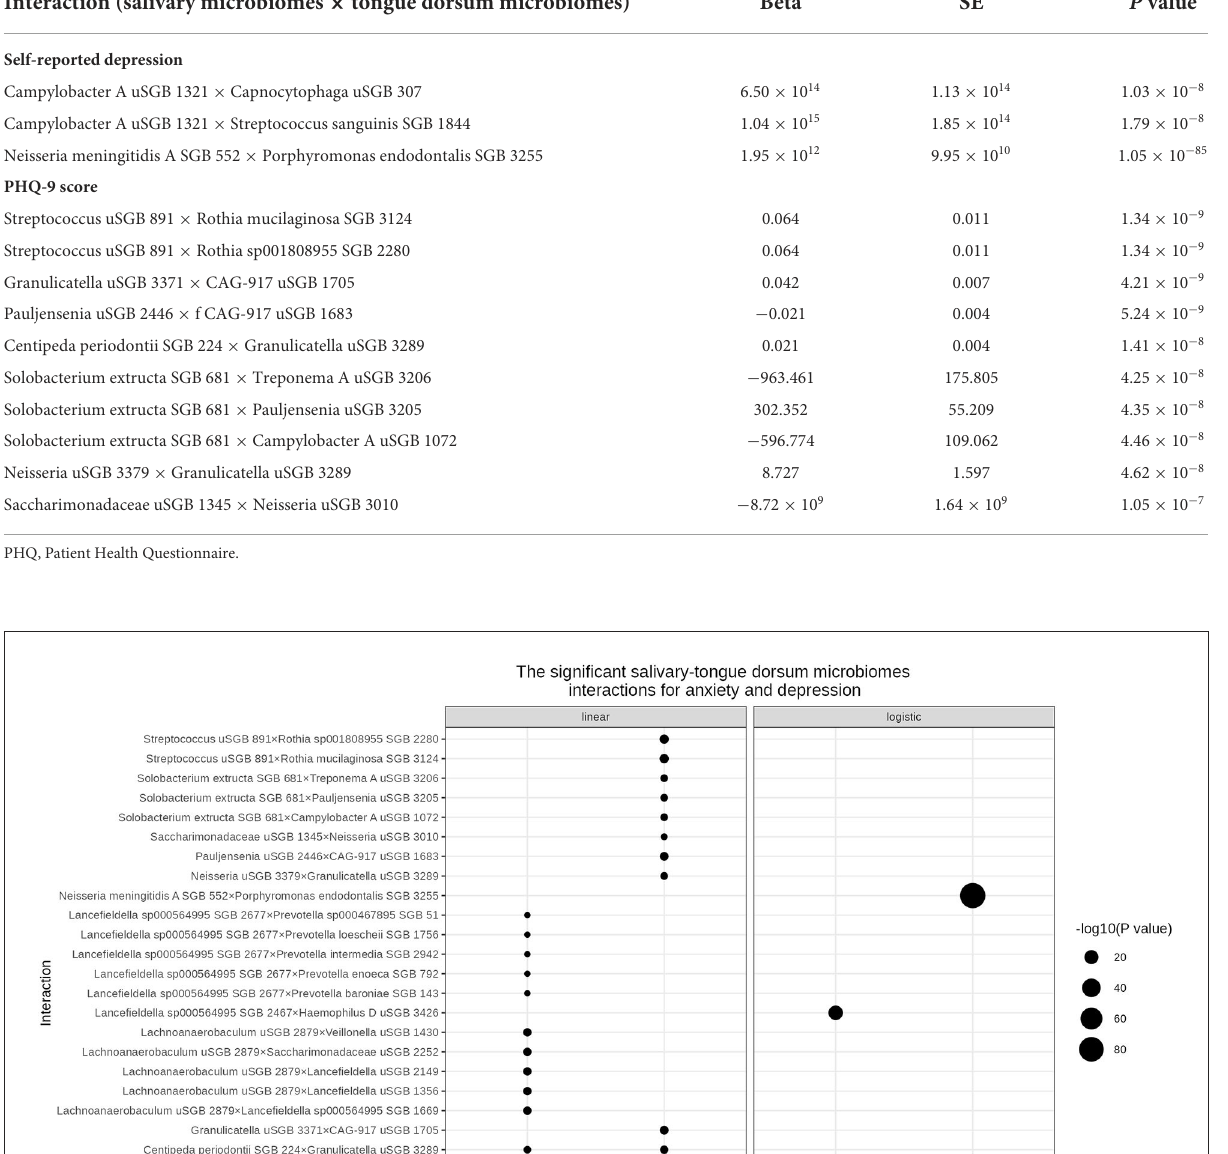
TABLE 2 The significant salivary-tongue dorsum microbiomes interactions for self-reported depression and PHQ-9 score. Interaction (salivary microbiomes × tongue dorsum microbiomes) Beta SE P value Self-reported depression